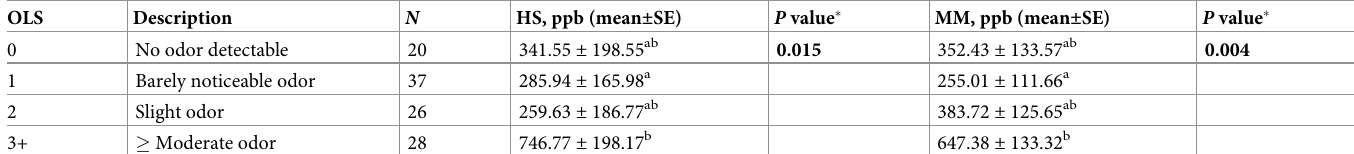
Table 2. Validation of the Organoleptic Scoring (OLS) of oral malodor against hydrogen sulfide (HS) and methyl mercaptan (MM) concentrations in mouth air ( n = 111). OLS Description N HS, ppb (mean ± SE) P value